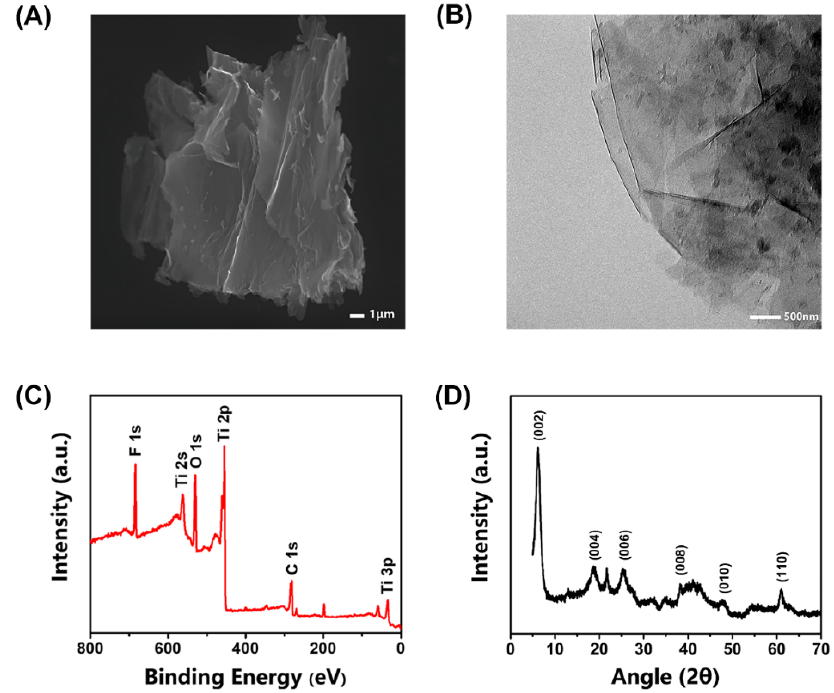
Figure 1. Characterizations of the synthesized MXene. ( A ) SEM image of MXene; ( B ) TEM pattern of MXene; ( C ) XPS survey scan of MXene; ( D ) XRD of the synthesized MXene.